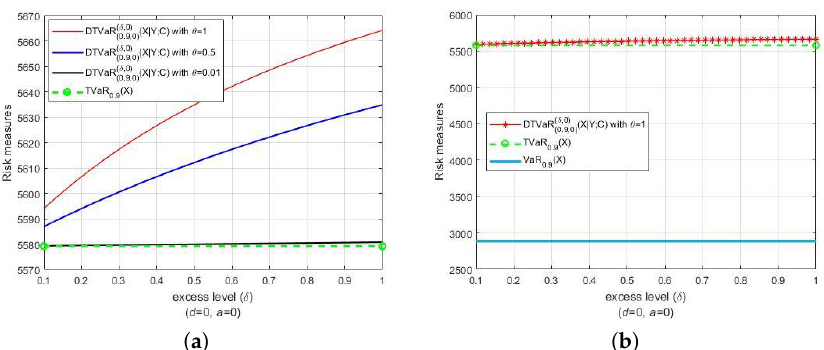
Figure 1. ( a ) DTVaR of the target loss X with associated loss Y for positive values of FGM copula parameter and a = d = 0 along with ( b ) its comparison with TVaR and VaR of X . Both X and Y are Pareto distributed ( γ 1 = 3, β 1 = 2500).